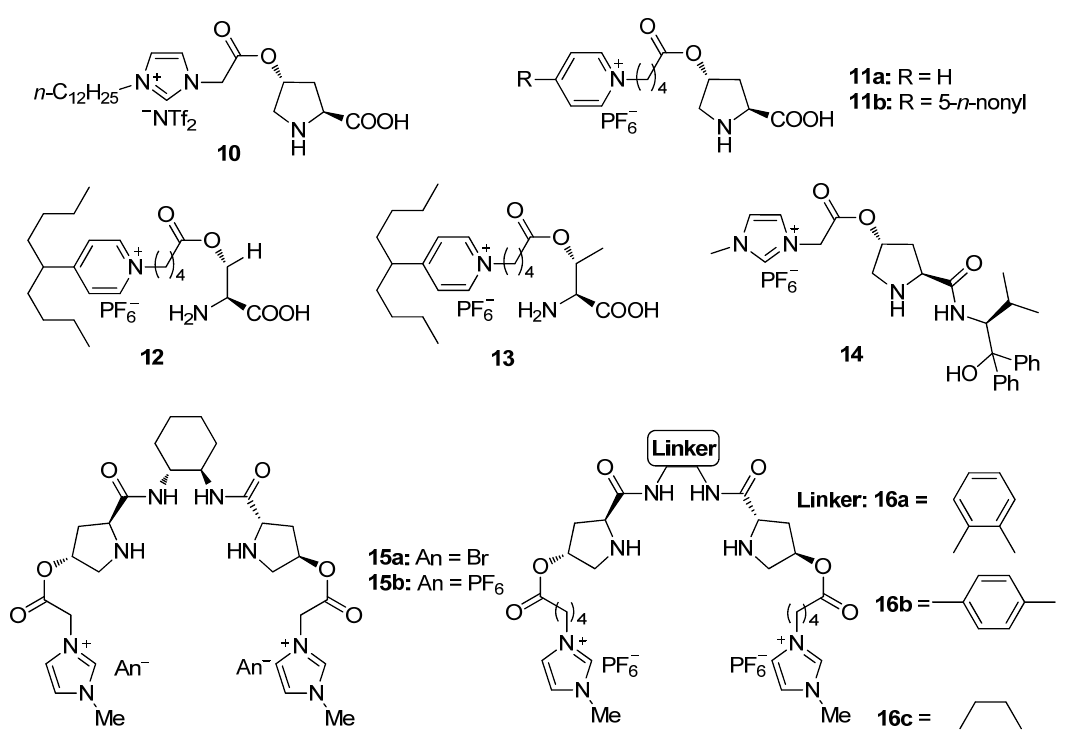
Figure 3. Different types of ionic liquid immobilized